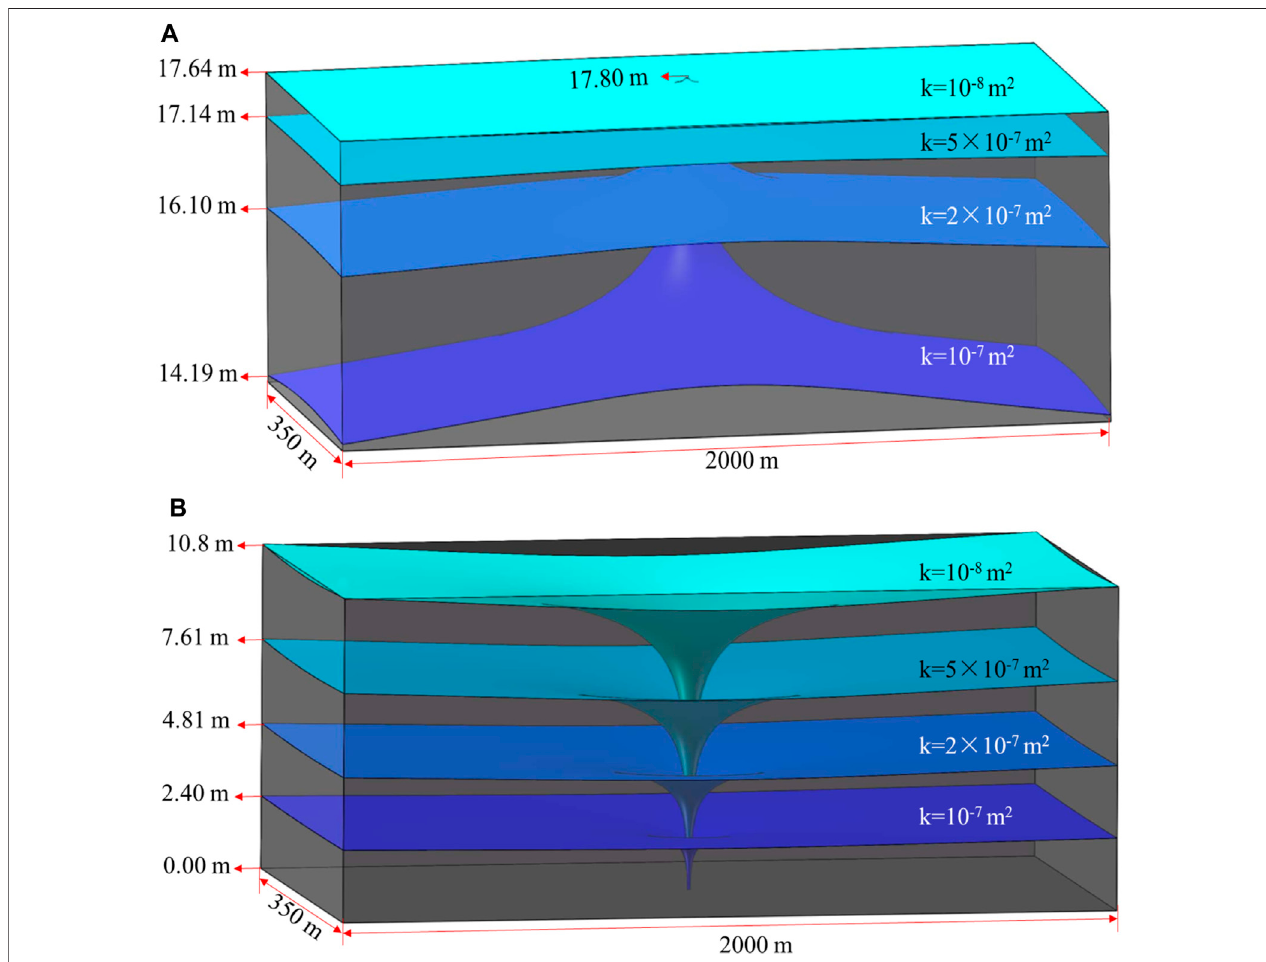
FIGURE 5 | Water saturation lines in the goaf reservoirs with various permeabilities (unit: m 2 ). (A) When the water level in the collection well reaches its maximum, 17.8 m; (B) When the water level in the collection well drops to 0 m; to ef fi ciently pump/inject water during charging/discharging, water-collecting wells are made at the centerofthegoafreservoirbottom.Water/air fl owvelocitywithinthereservoirisdeterminedbypressuregradientandpermeability.Toensuresuf fi cientoutputsofturbine and pumps, the maximum water fl ow should be guaranteed. The water saturation lines within the goafs were marked when the water fl ow in penstocks was constant at 6.25 m 3 /s. The maximum water level in the WCWs was set at 17.8 m in similar consideration of the maximum water head restriction (Bai et al., 2017; Pang et al., 2018).The minimum water level is 0. Figures 5A,B show the highest saturation line during water injection and the lowest saturation line during water releasing. As the permeability decreases, the saturation line tends to decline during injection and rise during releasing, implying a less water volume injected during fi lling and released during draining the reservoir and hence a smaller usable capacity of the goaf reservoirs.